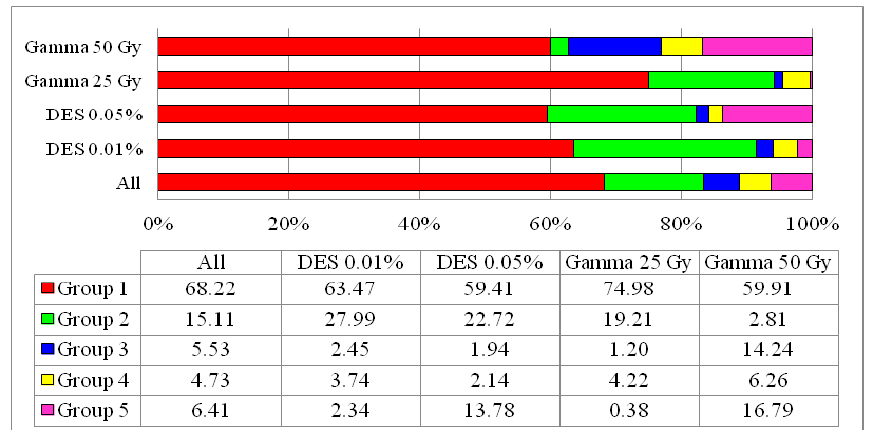
Figure 3. Membership coefficient (Q) means of mutated faba bean plants, inferred by the STRUCTURE program.